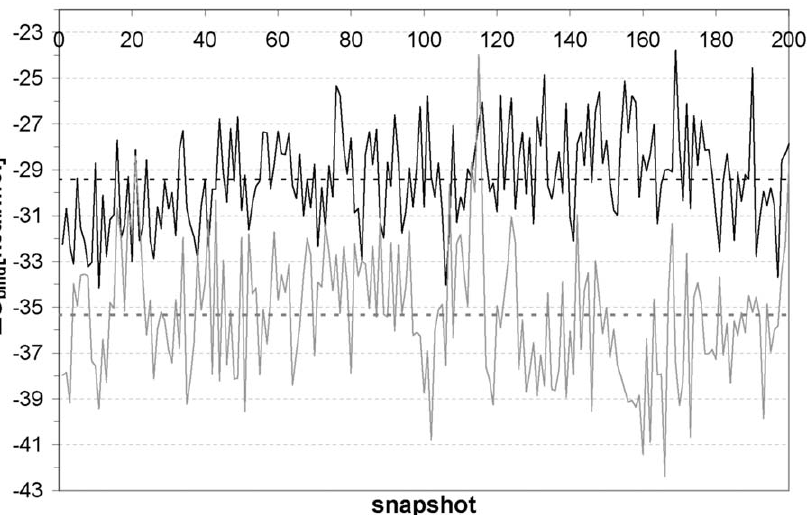
Figure 10. Time evolution for the binding free energy ( D G binding ) during a simulation run. Black line: T-p53C-Y220C-PhiKan083; gray line: 2nd modification of PhiKan083 (B) – T-p53C-Y220C; dotted black line: mean value for T-p53C-Y220C-PhiKan083; dotted gray line: mean value for the